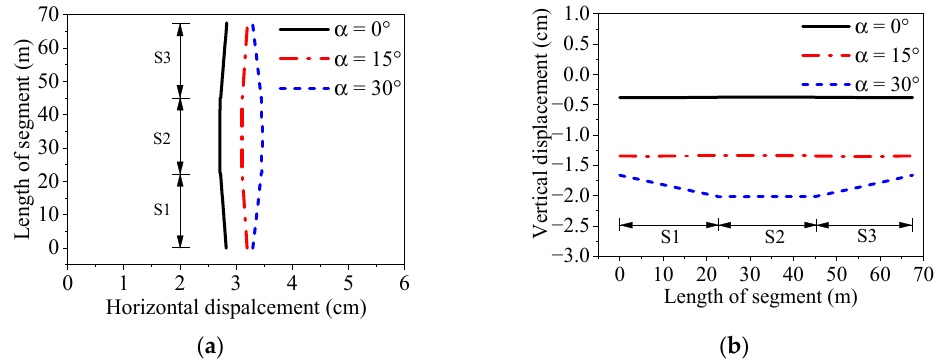
Figure 17. Horizontal and vertical displacements of segment at different angles of incidence: ( a ) horizontal; ( b ) vertical.